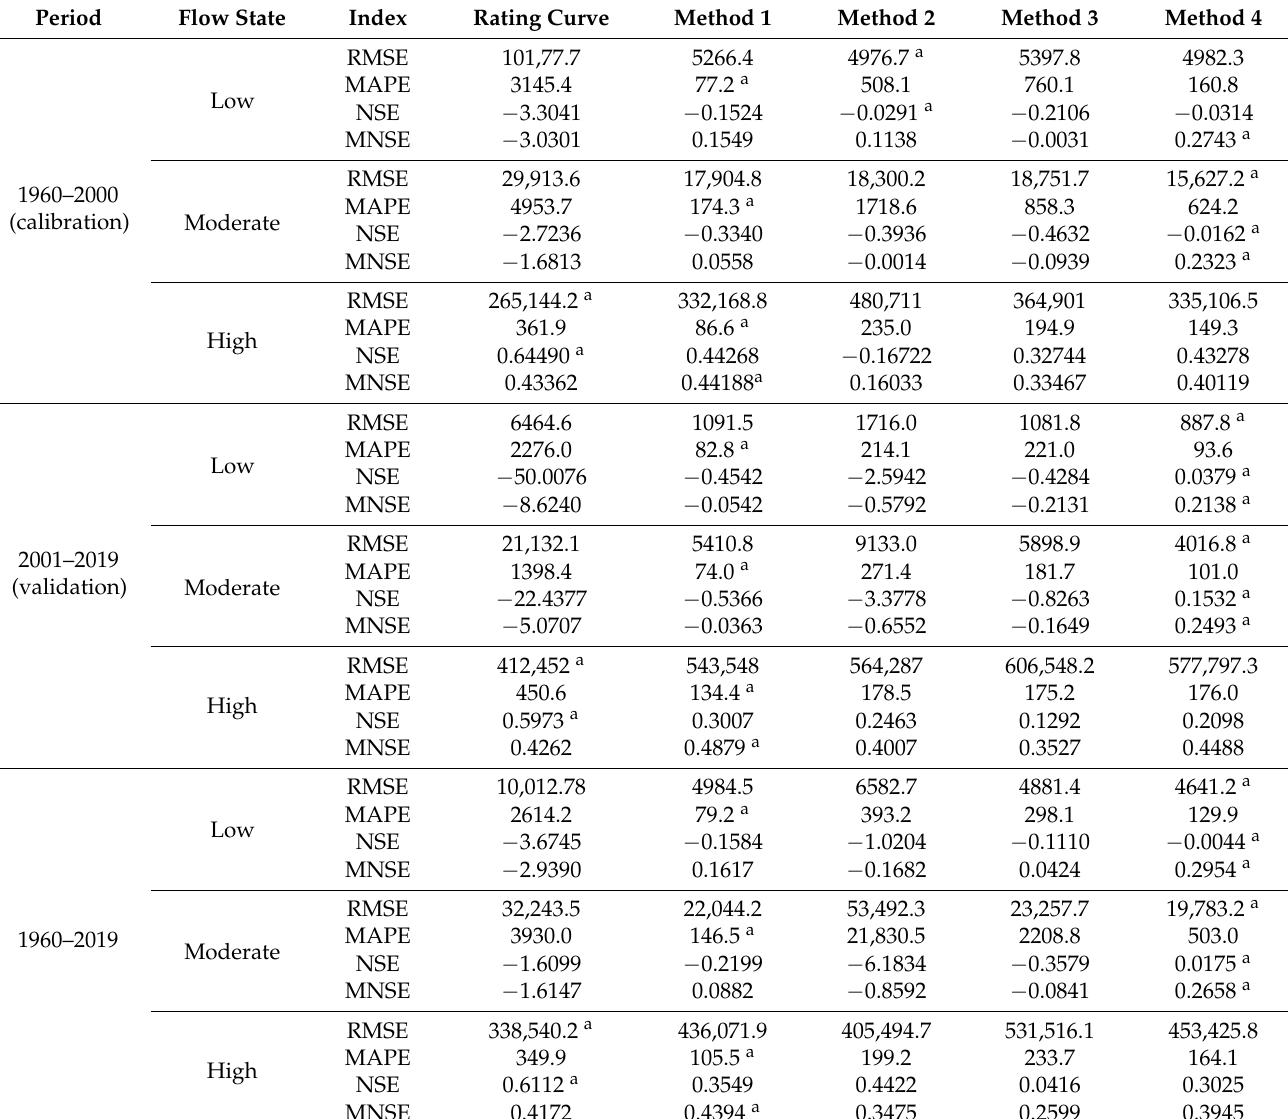
Table 5. The results of RMSE, MAPE, NSE, and MNSE of the periods of 1960–2000 (calibration), 2001–2019 (validation), and 1960–2019 for various streamflow